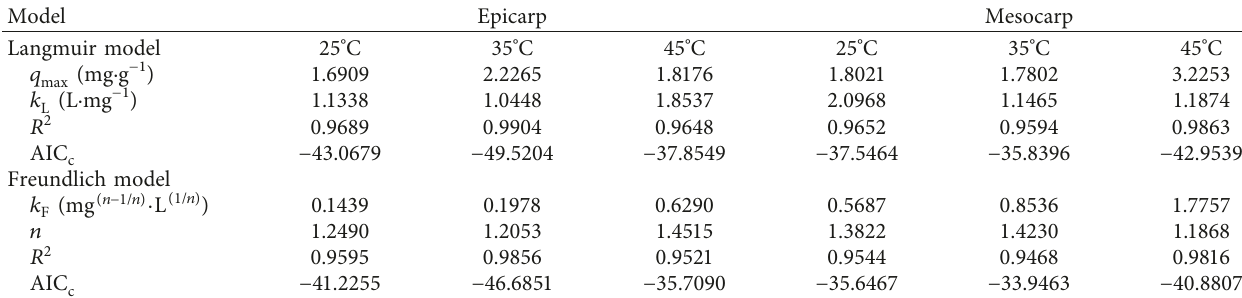
Table 3: The Langmuir and Freundlich models constants.